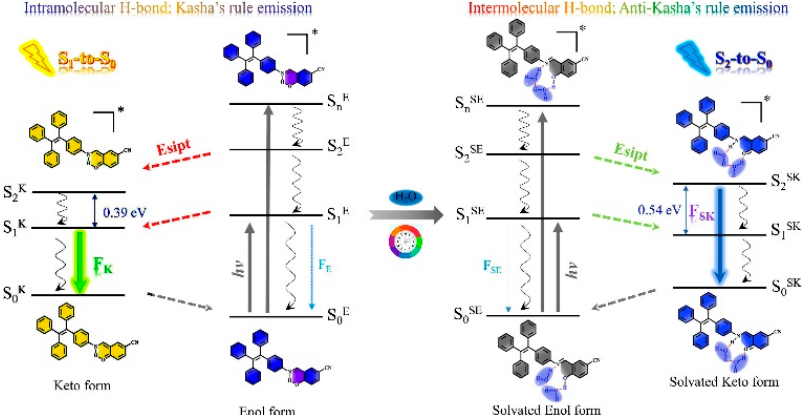
Figure 28. Possible mechanism for the dynamic stimuli-responsive fluorescence switch. S 0E : ground state of enol form of 104 ; S nE : excited state of enol form of 104 ; S 0K : ground state of keto form of 104 ; S nK : excited state of keto form of 104 ; S 0 SE : ground state of enol form of solvated 104 ; S nSE : excited state of enol form of solvated 104 ; S 0 SK : ground state of keto form of solvated 104 ; S nSK : excited state of keto form of solvated 104 . Adapted from [86], Copyright 2021, with permission from